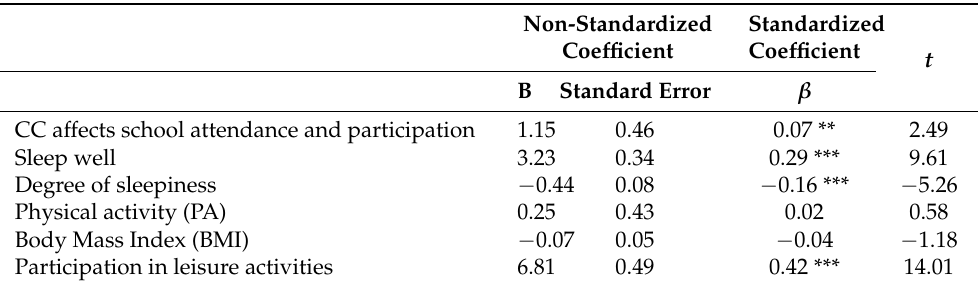
Table 5. Linear regression model of variables for the study of the QoL—predictors: CC affects/does not affect school participation and variables associated with lifestyle (sleep, physical activity, BMI, and